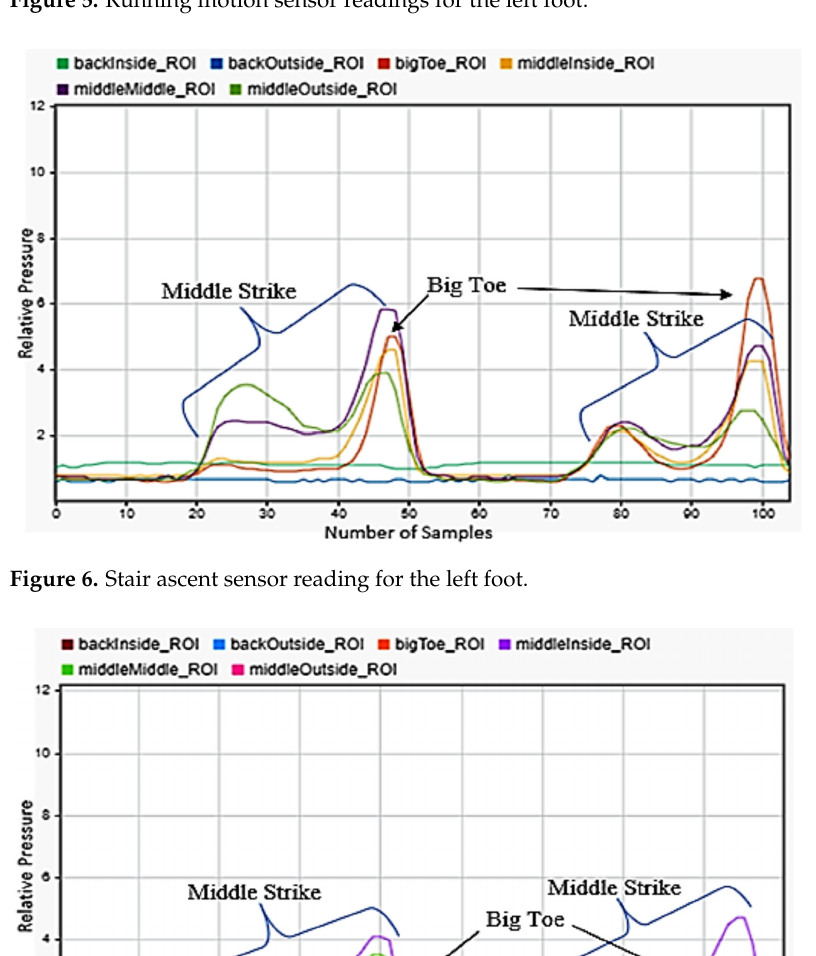
Figure 6. Stair ascent sensor reading for the left foot.